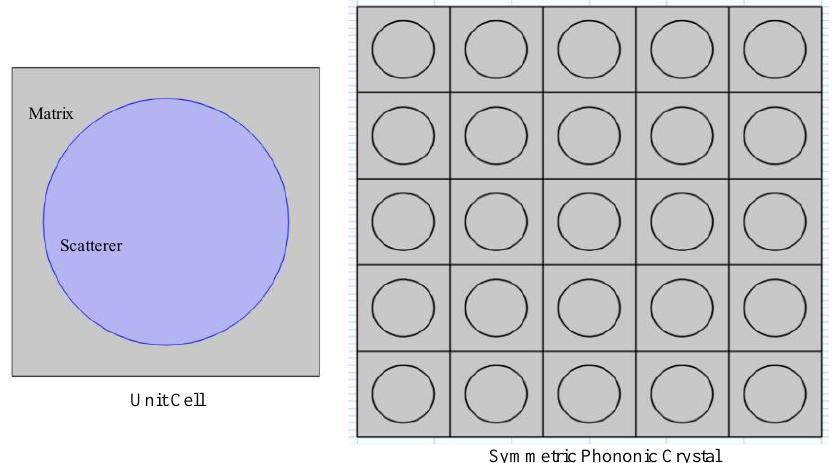
Figure 1. Symmetric Bragg’s scattering panel with unit